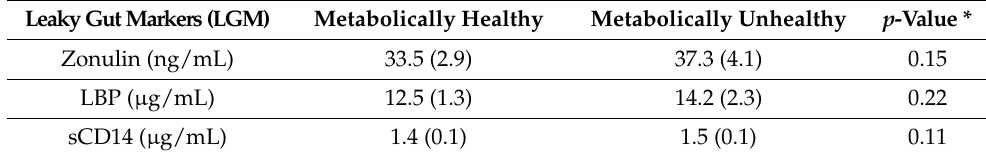
Table 3. LGM levels of metabolically healthy ( n = 14) and metabolically unhealthy ( n = 14) subjects in the unchallenged MS permeability